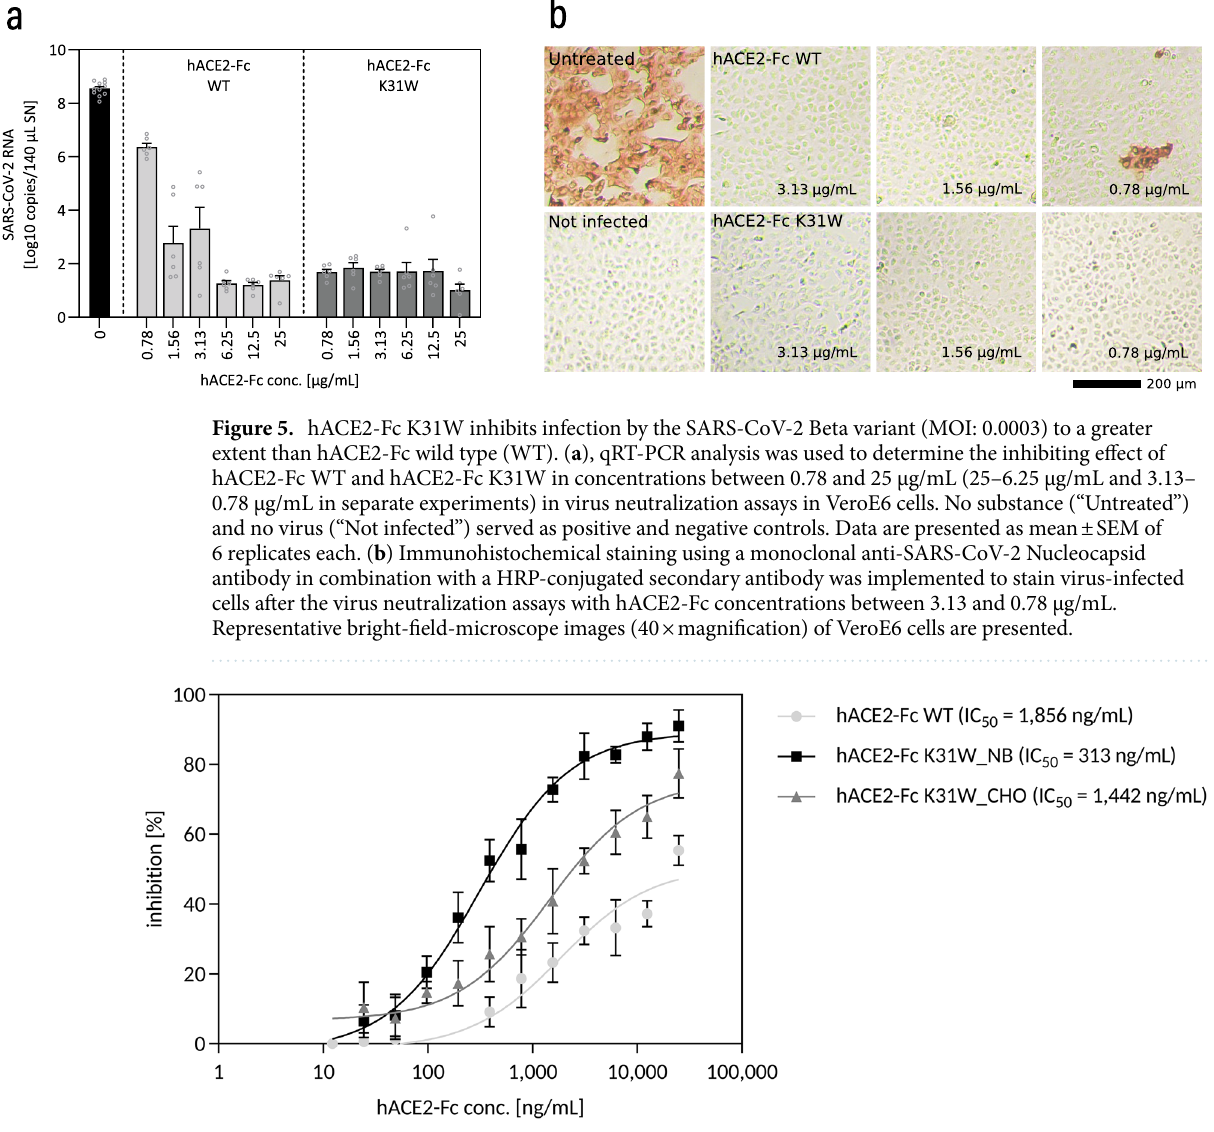
Figure 6. hACE2-Fc K31W expressed in N. benthamiana (hACE2-Fc K31W_NB) has higher inhibitory activity against spike RBD binding to immobilized wild-type hACE2-Fc compared to the same variant expressed in CHO cells (hACE2-Fc K31W_CHO) and compared to wild-type hACE2-Fc (hACE2-Fc WT) produced in CHO cells. Soluble hACE2 variants were preincubated with spike RBD protein before being added to the wells of an assay plate precoated with hACE2. The binding of spike RBD to well-surface hACE2 was determined by an ELISA-based competitive inhibition assay in two independent experiments. Data are presented as mean ± SD of duplicates from one representative